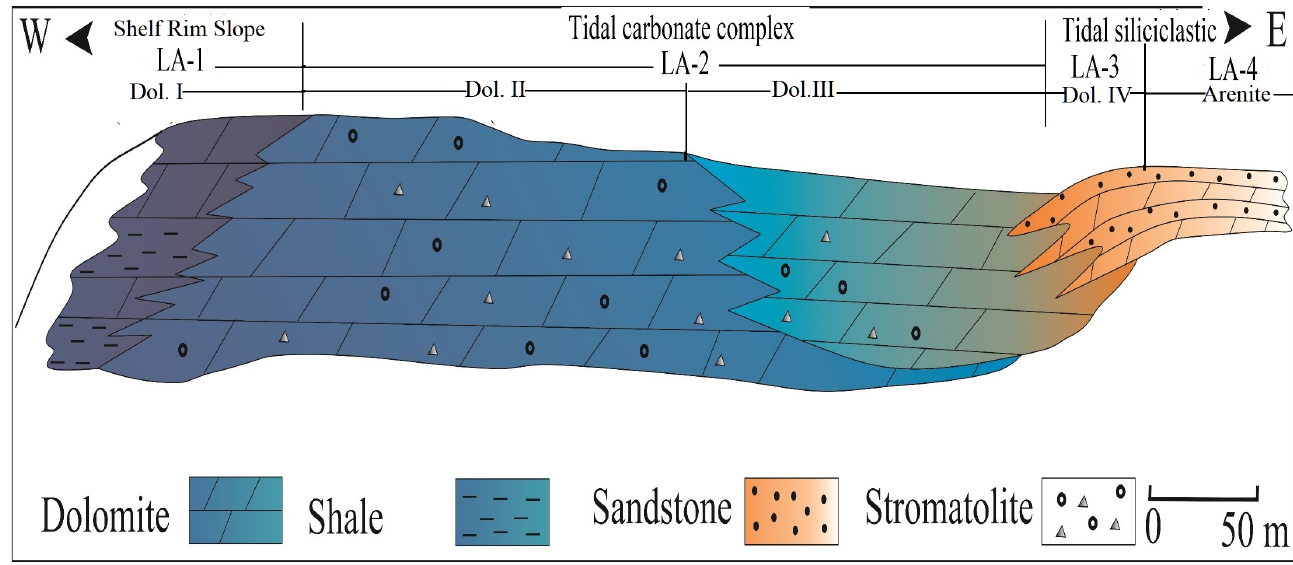
Figure 13. Depositional model showing the lateral facies distribution of the Abbottabad Formation from west ( left ) to east ( right